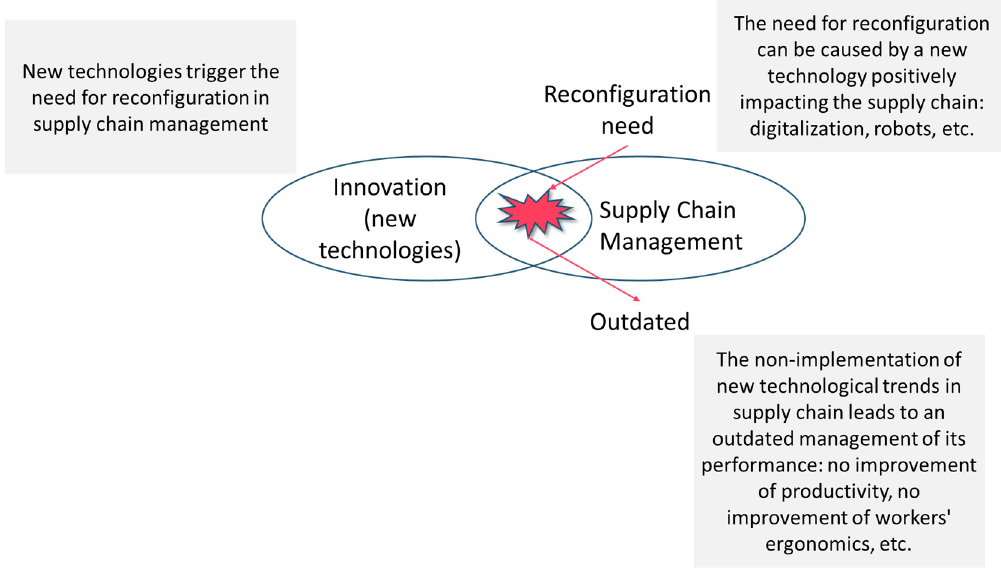
Figure 3. Impact of the innovation on supply chain management.